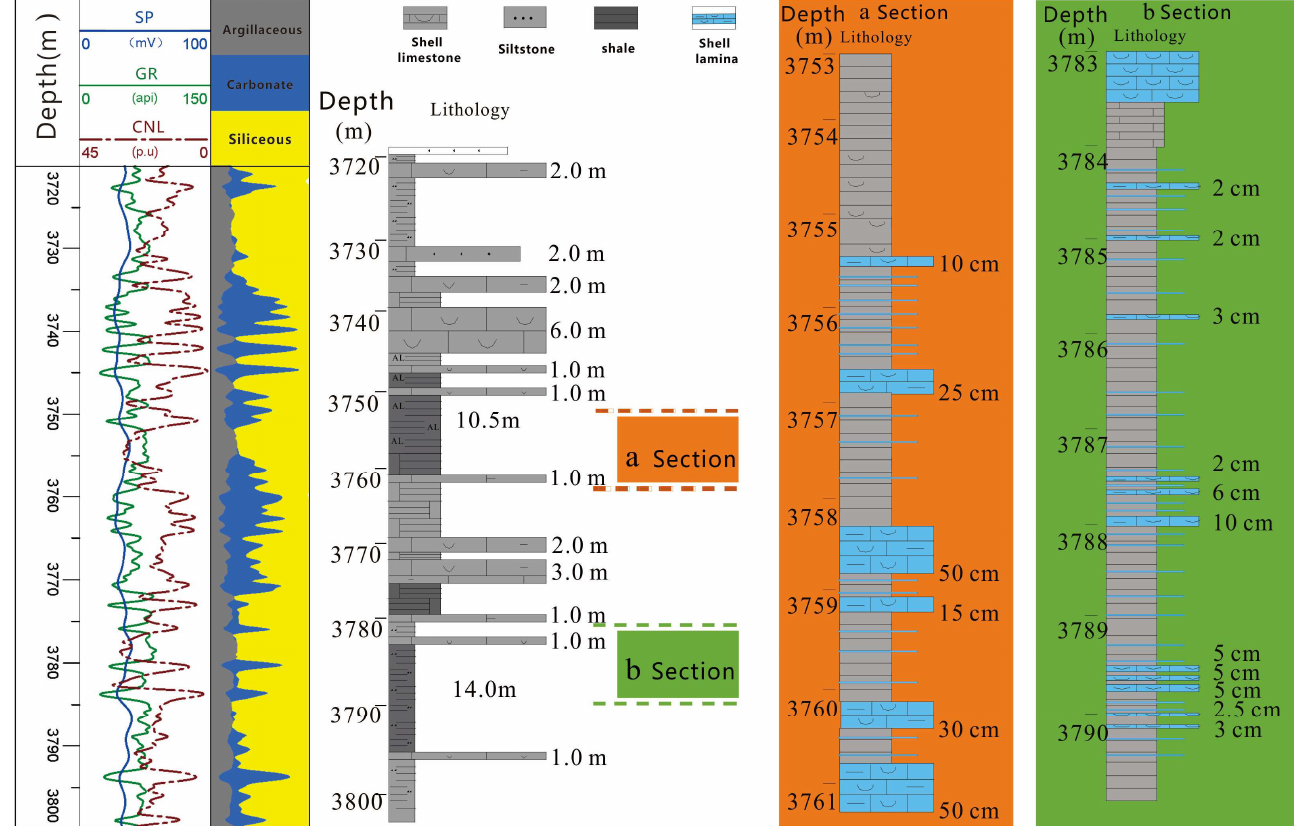
Figure 11. Lithofacies combination characteristics of continental shale in Well XA.